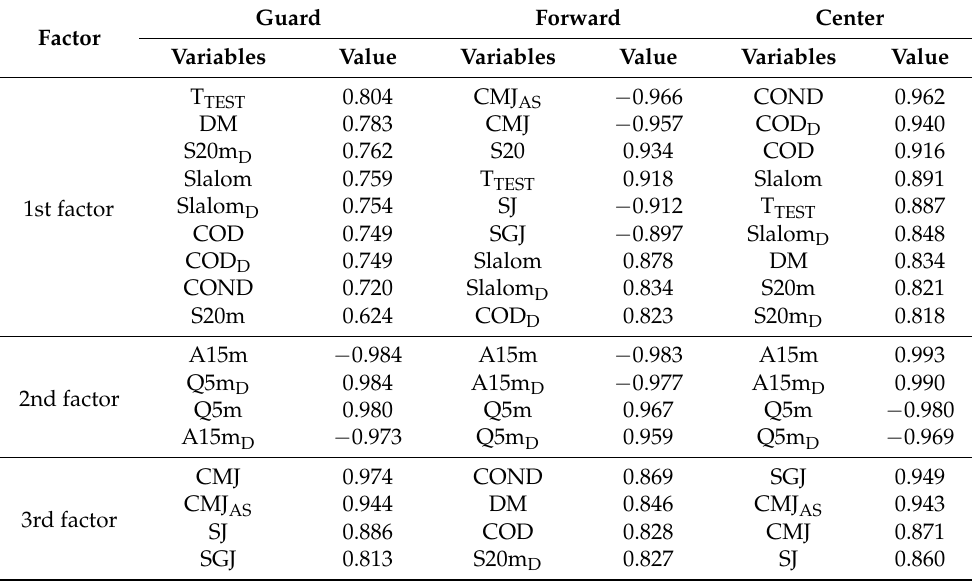
Table 3. Factor analysis structure matrix for each playing position. Factor